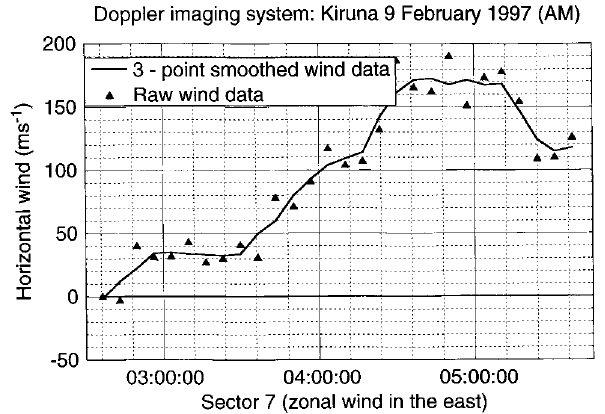
Fig. 11 The zonal wind measurement by DIS a.m. Feb 9 1997: Comparison between ( j ) raw and (—)